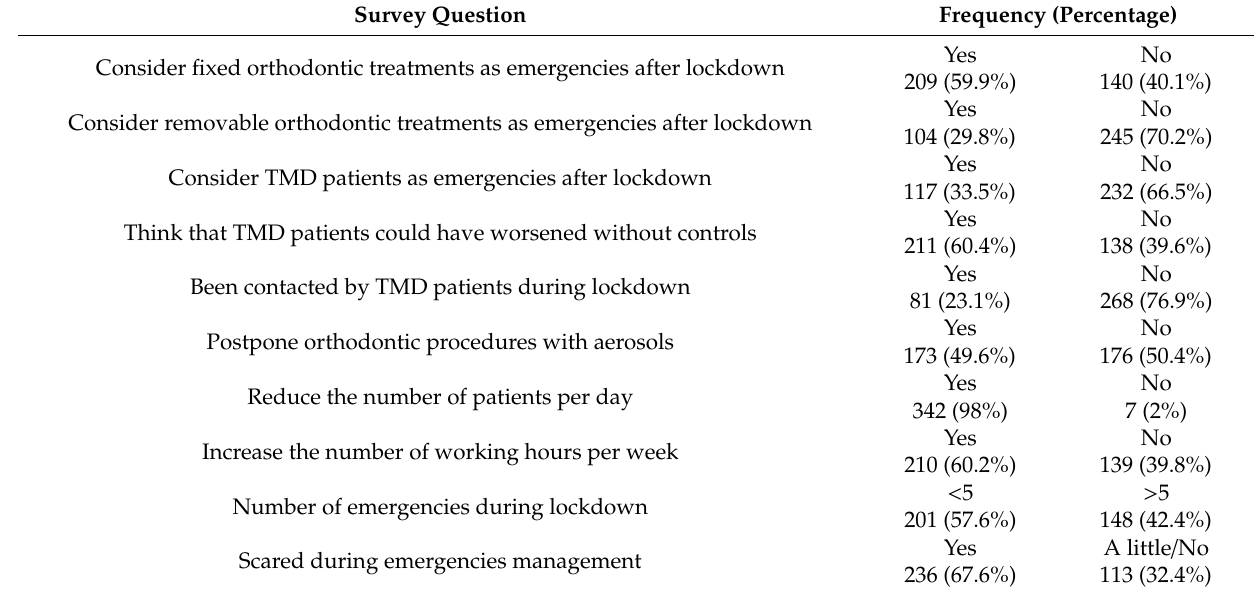
Table 4. Frequencies and percentages of replies to questions about orthodontic and TMD patients, emergencies and changes in clinical procedures and work organization. Survey